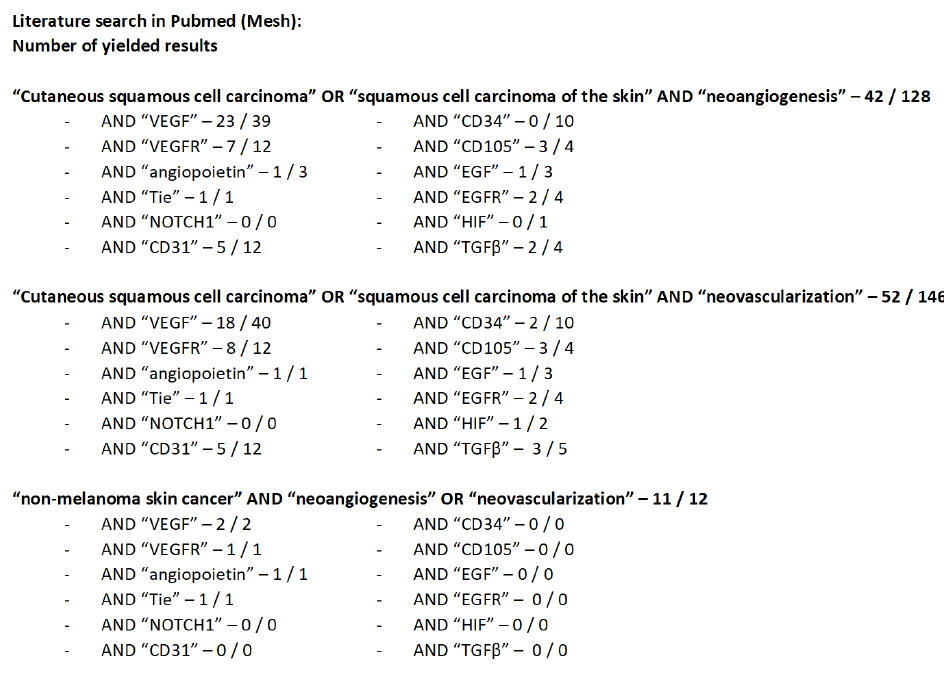
Figure 1. The search terms and the yielded results.